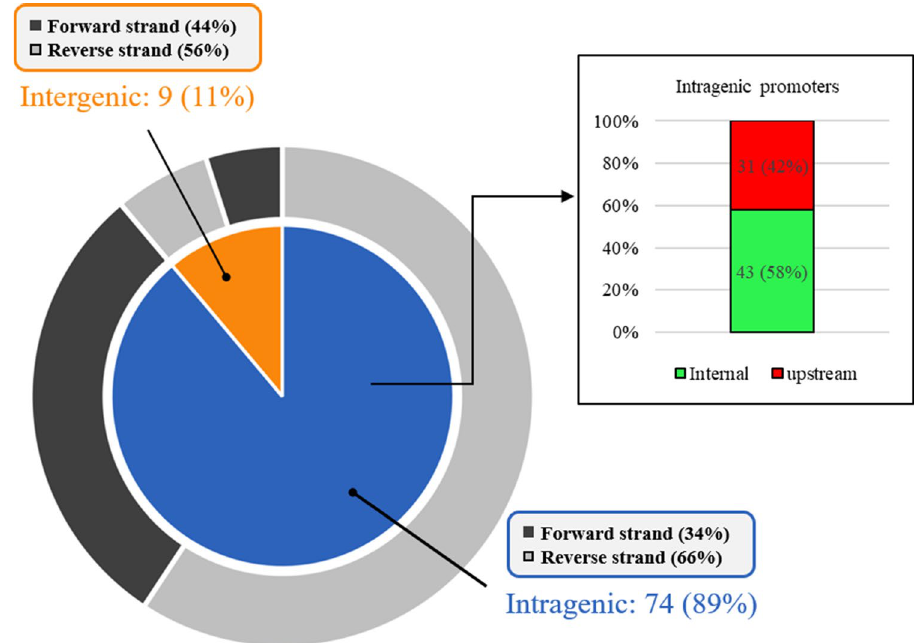
Figure 2. Locations of putative PK/NRP σ 54 promoters identified in the M. xanthus genome. Of the 83 putative PK/NRP σ 54 promoters identified in M. xanthus genome sequence, 74 (89%) are located in protein coding sequences (intragenic promoters) and 9 (11%) are located in non-coding sequences (intergenic promoters). Of the 74 intragenic promoters, 43 are located within a protein coding sequence in an operon or within the protein coding sequence of a single gene (internal promoters), and 31 are located in the protein coding sequence of an upstream gene (upstream